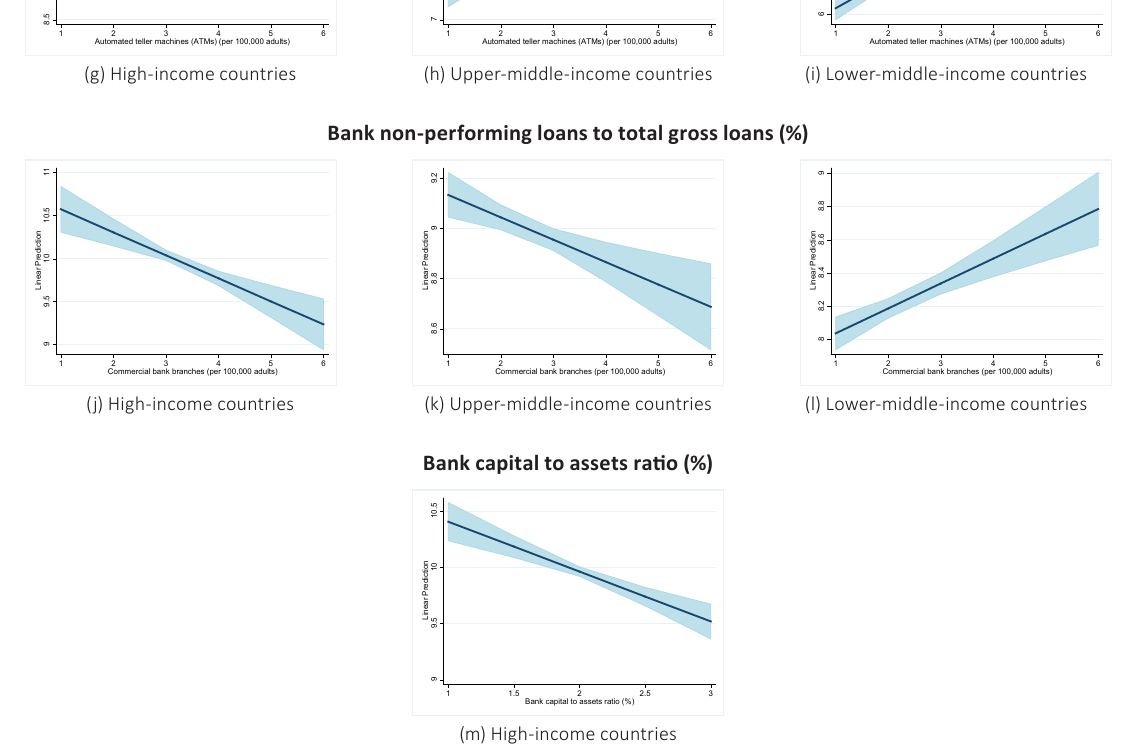
Figure A1. Predictive margins with 95% for independent variable by